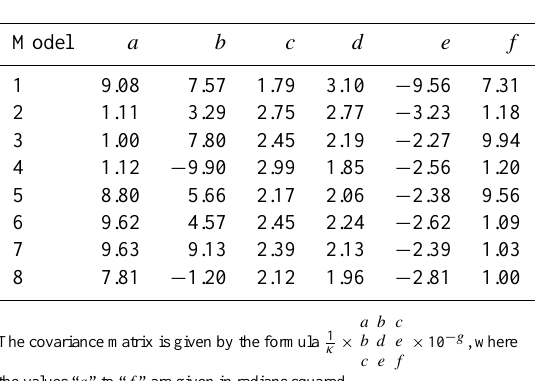
Table 2. Rotation covariance for North America–Greenland recon- structions.